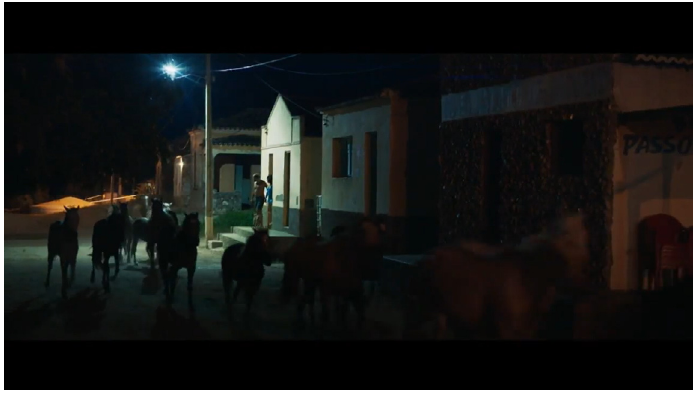
Figure 2. Film still, Bacurau